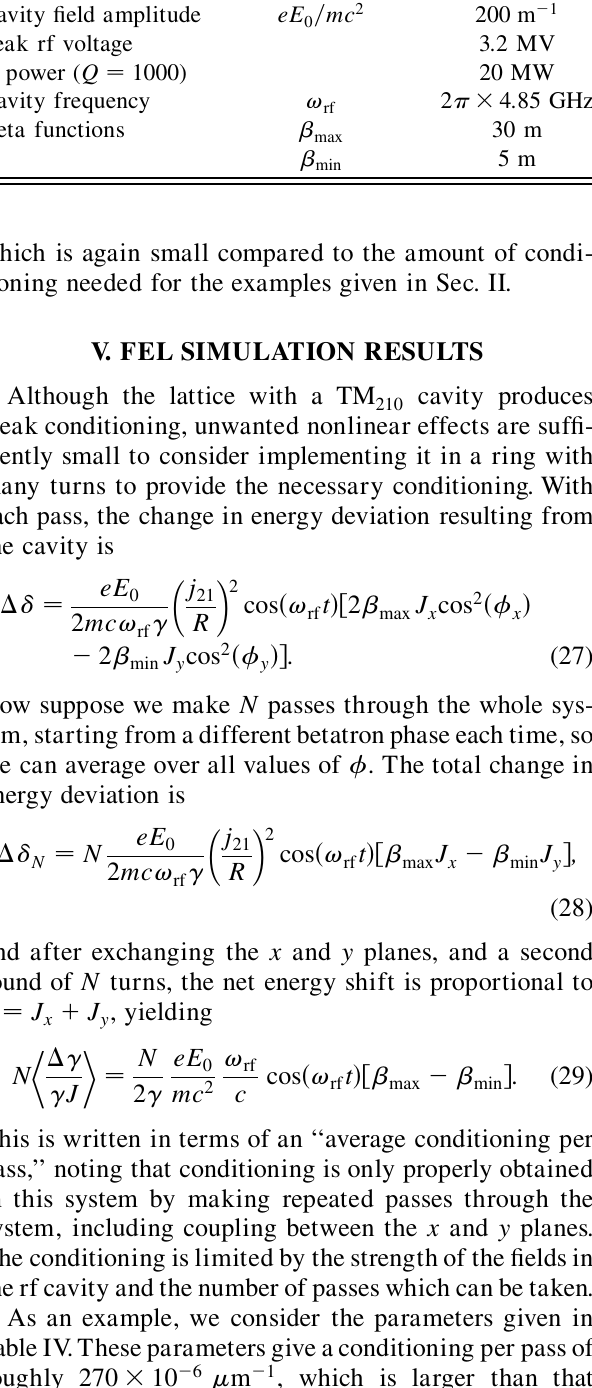
FIG. 10. (Color) Results of GENESIS simulations using LCLS parameters. FEL performance of 4 : 8 (cid:27) m emittance ( 4 (cid:13) nomi- cavity lattice (blue line nal) conditioned beam from TM 210 with squares) is compared with performance of a similar, ideally conditioned beam (black dashed line) and of the nomi- nal, unconditioned case (red diamonds); see Fig.